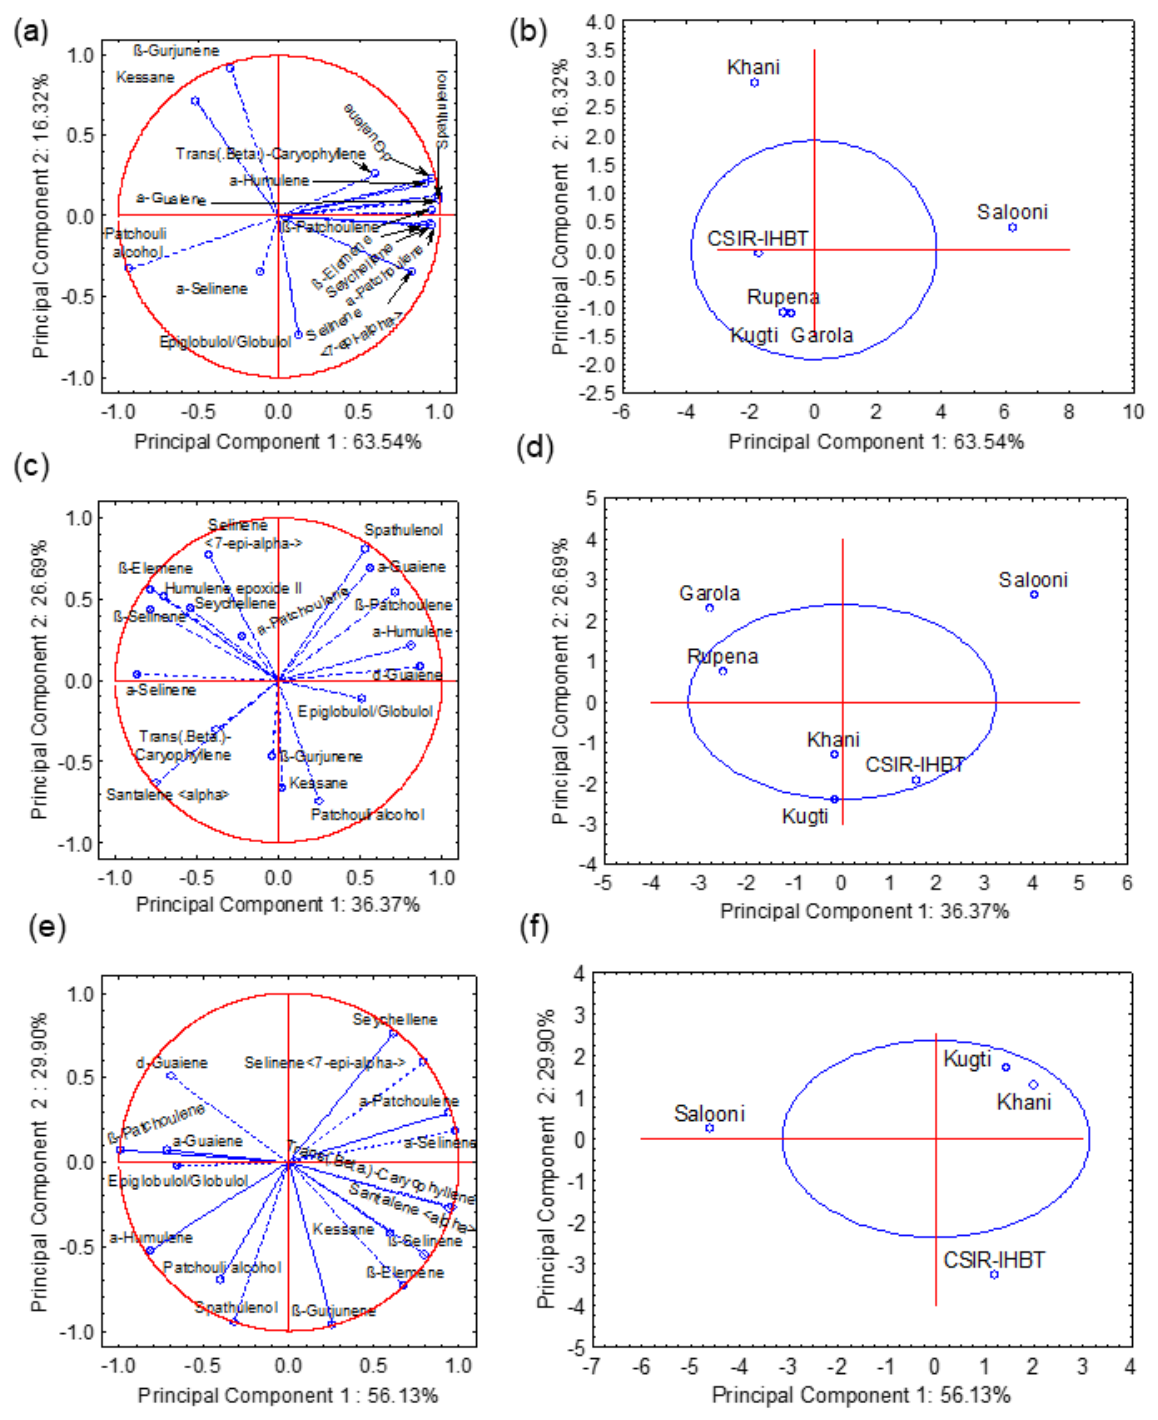
Figure 5. Principal component analysis of chemical compositions of essential oil in the different populations of V. jatamansi during first day ( a , b ), second day ( c , d ), and third day ( e , f ) of distillation. During the second day of distillation, β -patchoulene, α -guaiene, α -humulene, and δ - guaiene were situated in the positive coordinate of PC1, with loading values of 0.81, 0.56, 0.81, and 0.87, respectively (Figure 5c). Compounds such as β -elemene, α -santalene, β -